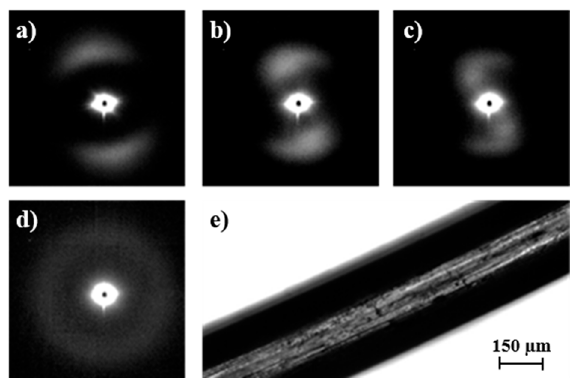
Figure 14. SAXS patterns taken at representative temperatures of 25 °C ( a ); 102 °C ( b ) and 112 °C ( c ) during a heating run at 10 °C/min of a PDO suture previously degraded in a pH 7 hydrolytic medium for 36 days. The pattern obtained at room temperature after cooling (10 °C/min) and the optical micrograph of the degraded suture are shown in ( d , e ), respectively.